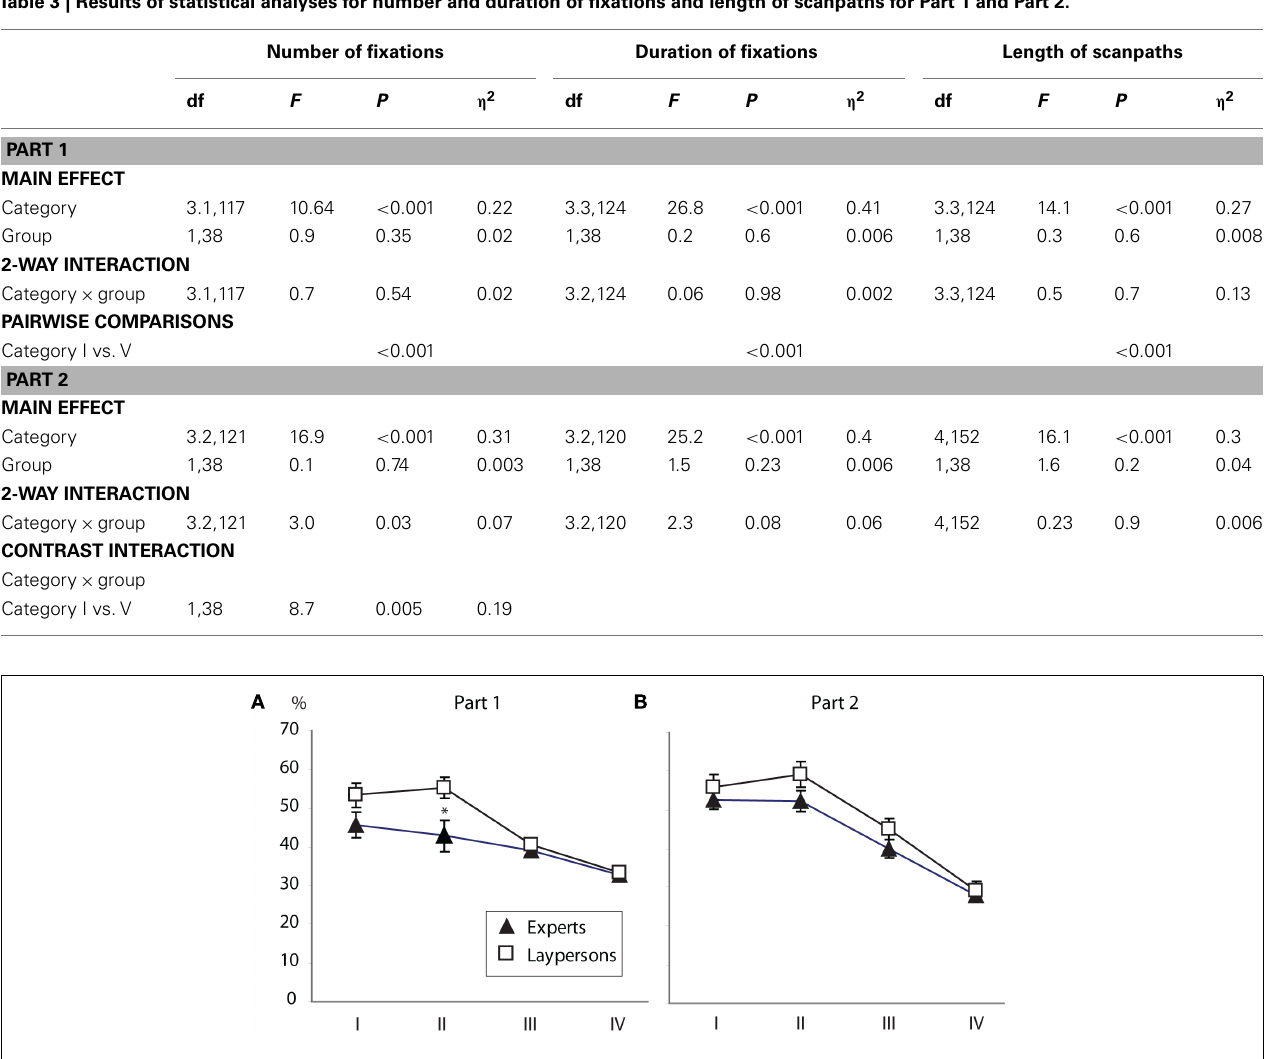
FIGURE 4 | Mean total fixation times (as percentage of viewing time) on head ROIs for Part 1 (A) and Part 2 (B). * denotes statistically significant difference for groups in Category II.